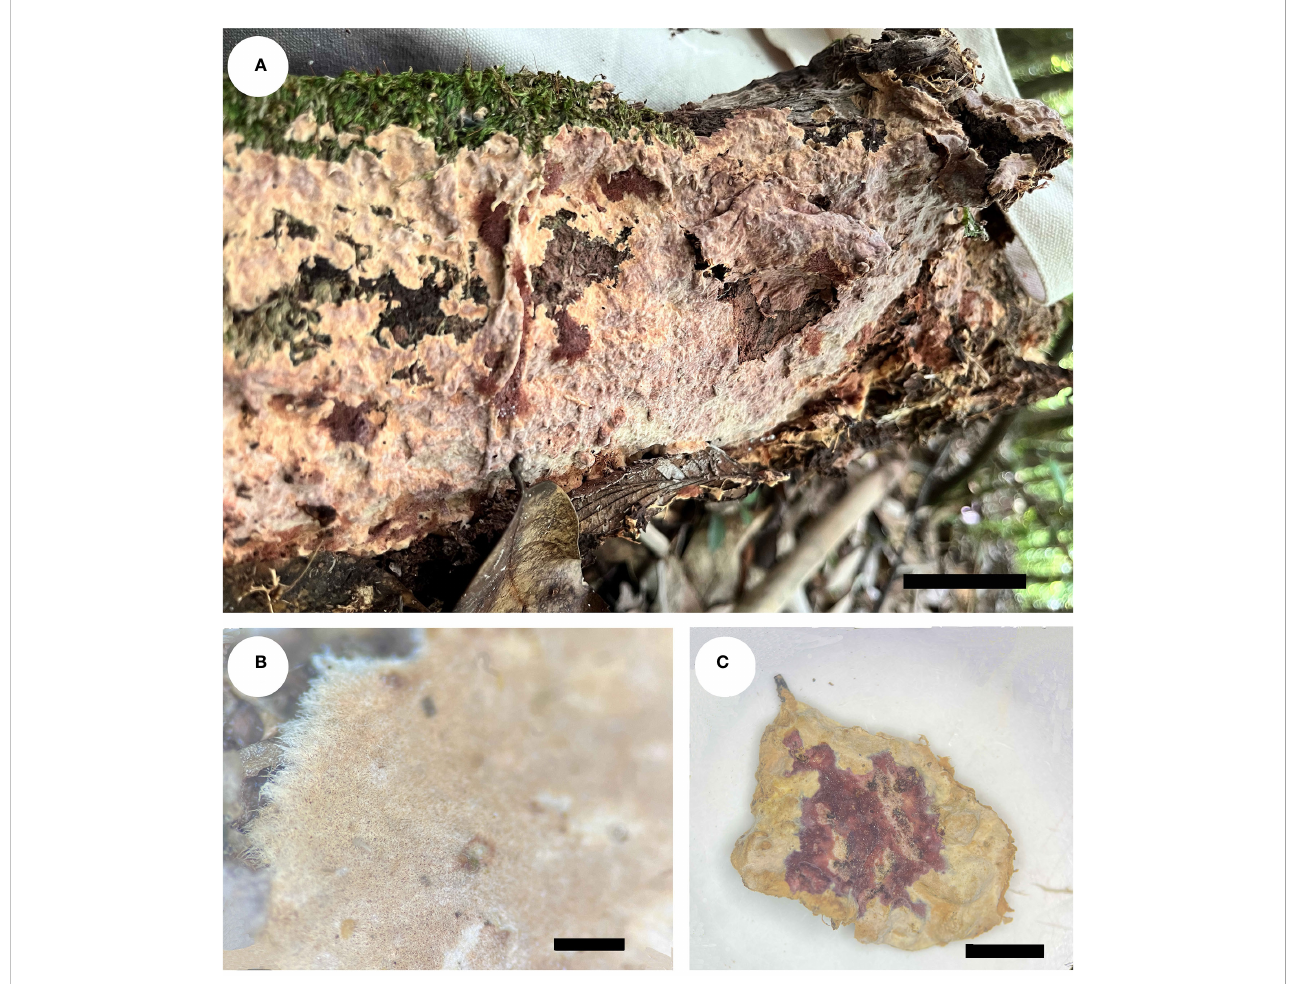
FIGURE 3 Basidiocarps of Rhizochaete variegata (holotype, Dai 24600). (A) In situ . (B) Detailed view of the margin. (C) Reaction with KOH. Scale bars: (A) = 1 cm, (B) = 1 mm, (C) = 0.5